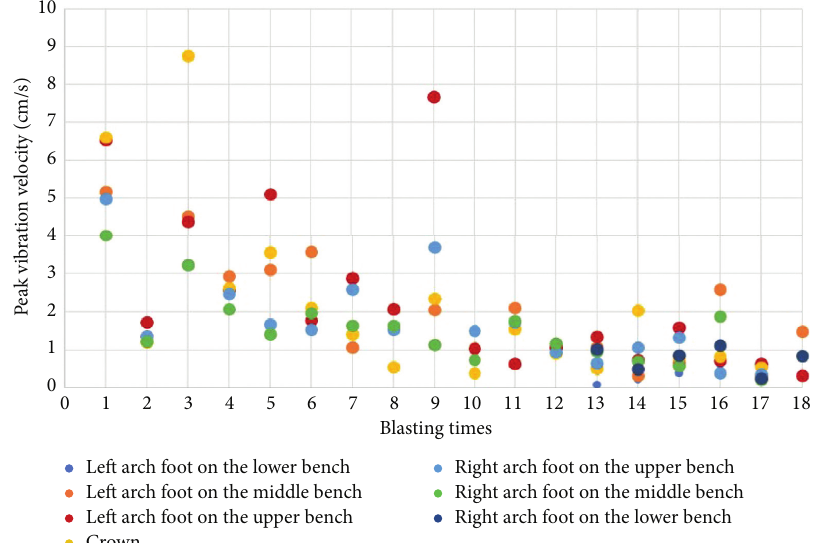
Figure 12: Contrast diagram of radial vibration velocity at different positions of the